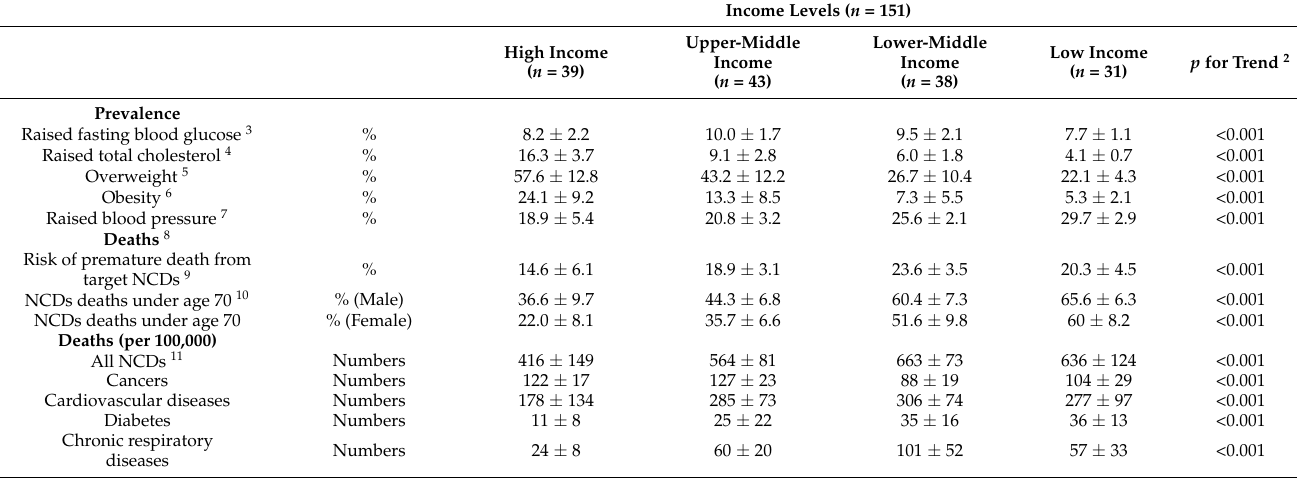
Table 1. Characteristics of the metabolic risk factors of NCDs and mortality of NCDs by income level 1